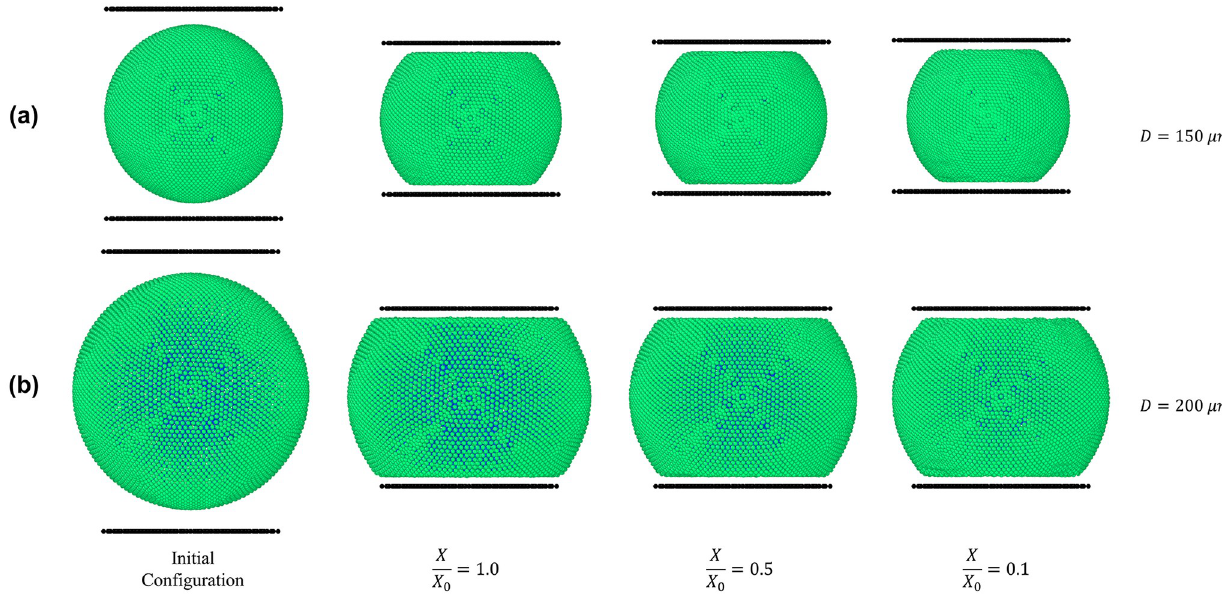
Fig 17. SPH-CG model predictions for compression of dried cells of different cell sizes. (a) smaller cell (generic) ( D = 150 μ m); (b) larger cell ( D = 200 μ m); ( D is the cell diameter and X/X is the normalised moisture content). 0